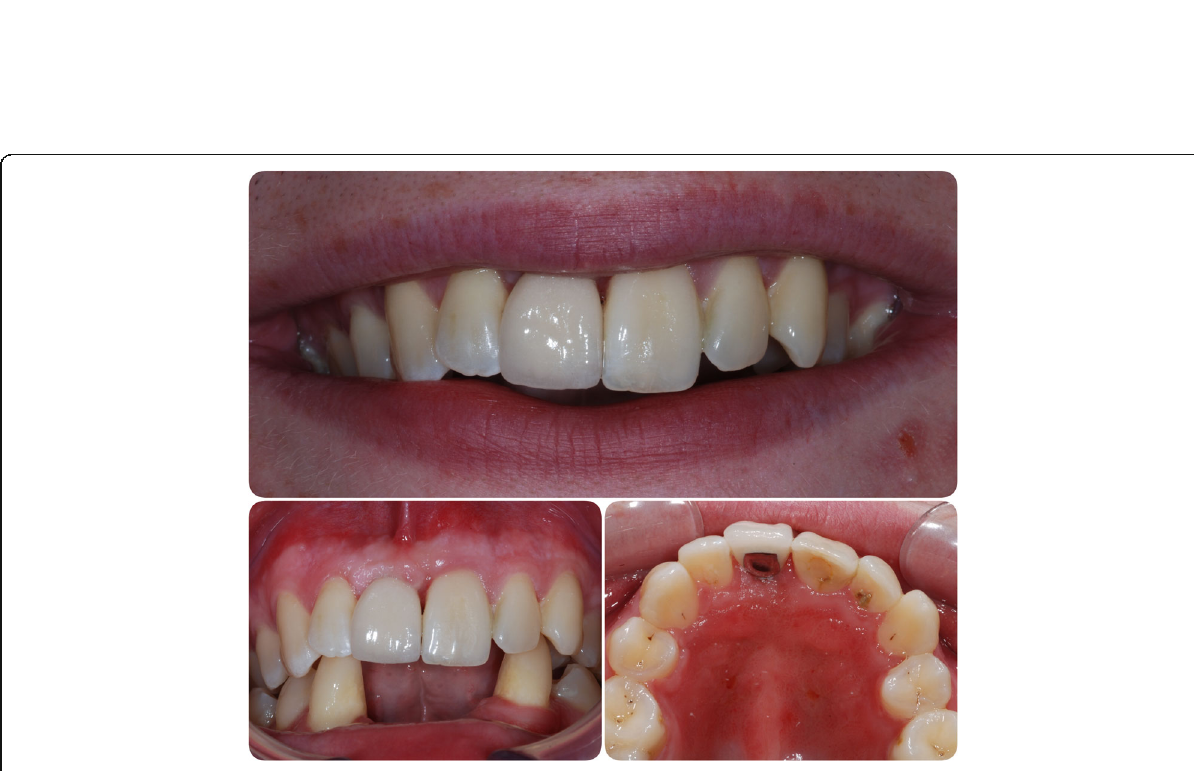
Fig. 5 Maxilla restored. Restored fixture in 11 position, 31 and 41 position fixtures remains unrestored as awaiting a connective tissue graft due to a narrow band of attached gingivae labial to the